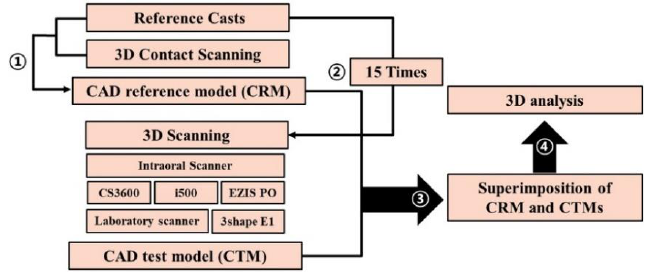
Figure 1. Experimental design.